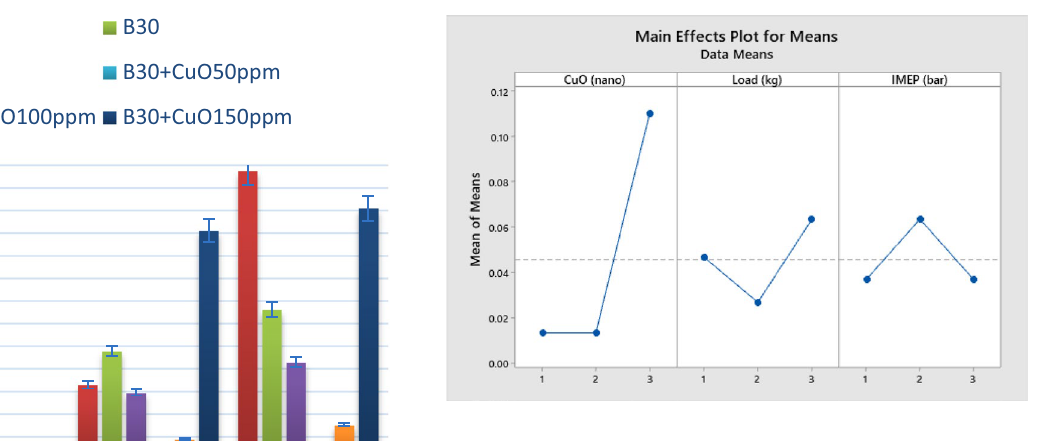
versus blend, load (kg), IMEP